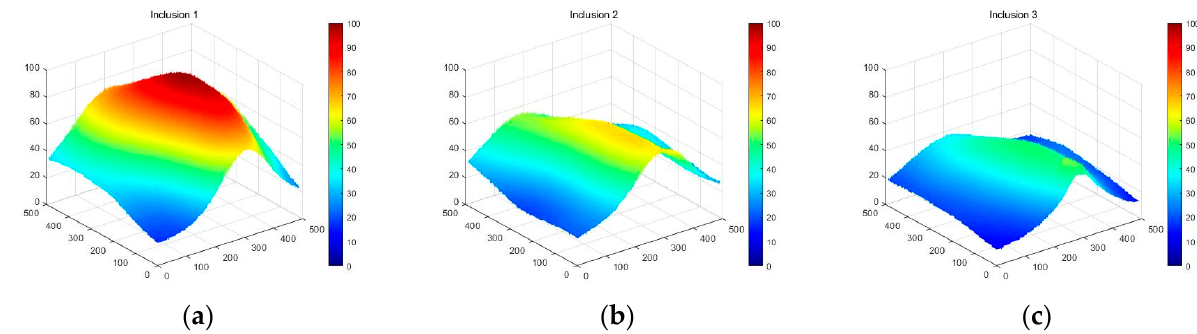
Figure 26. Three-dimensional elasticity-image simulation by depth: ( a ) 3 mm, ( b ) 5 mm, ( c ) 7 mm.